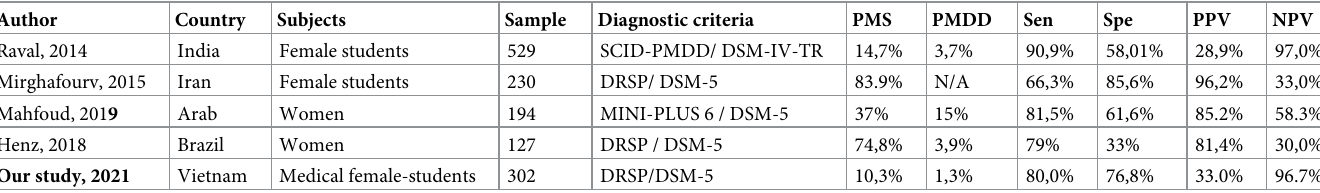
Table 5. Summary of studies on the validity of Premenstrual Syndrome Screening